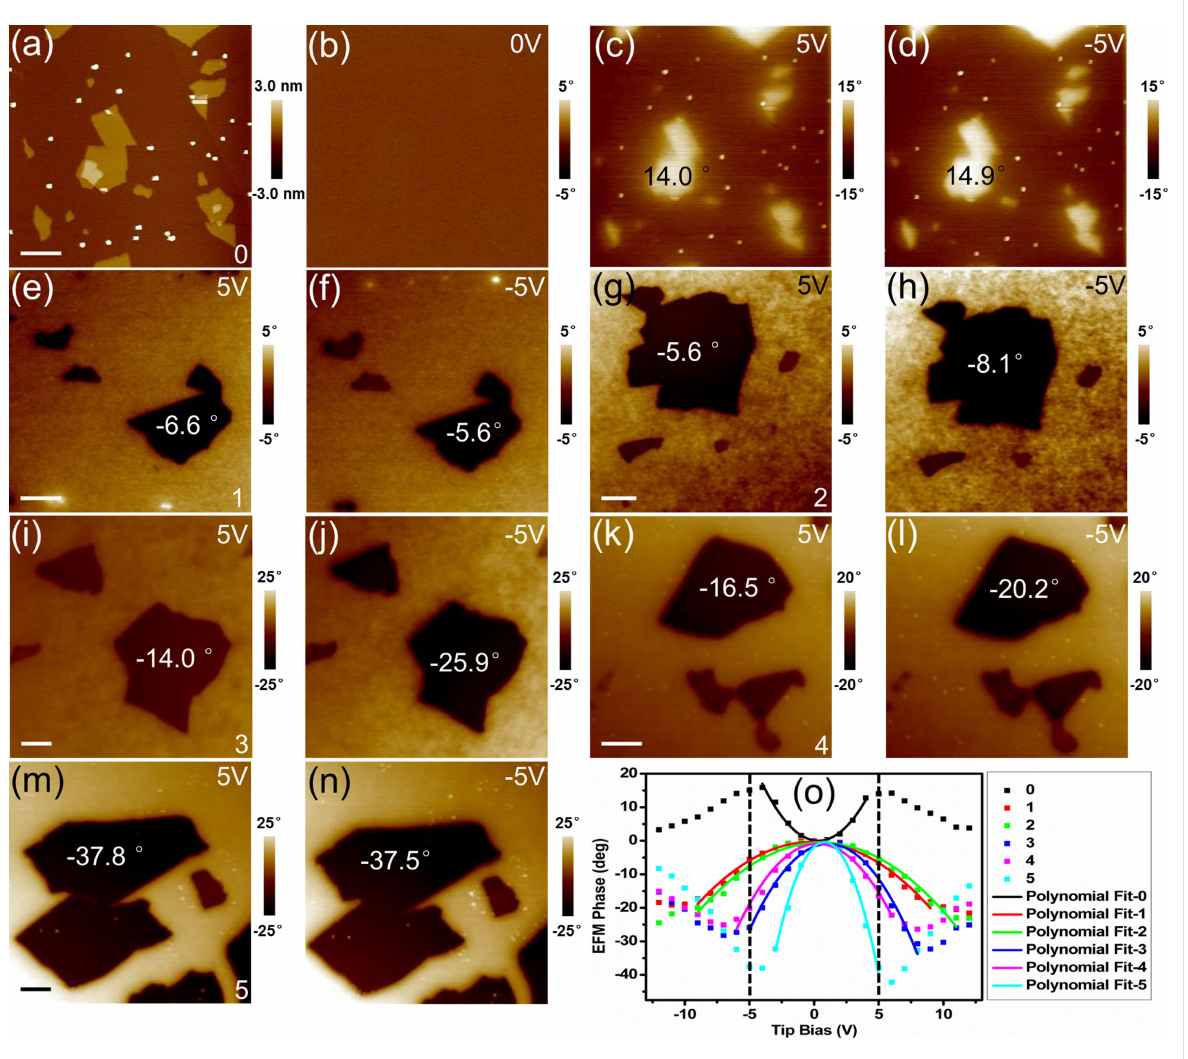
Figure 2: Characterizing the degree of reduction of GO sheets using EFM imaging and EFS: (a) tapping AFM image and in situ EFM images with tip biases of (b) 0 V, (c) 5 V and (d) − 5 V of sample 0; EFM images of (e, f) sample 1, (g, h) sample 2, (i, j) sample 3, (k, l) sample 4, and (m, n) sample 5; (o) EFM spectra and the corresponding polynomial fits of samples 0–5 (the dashed vertical lines show the position of the biases at which images (c–n) were recorded). The number in the bottom right corner of the images represents the sample number. The upper right corner shows the tip bias used in the EFM imaging. The EFM phase contrast of the samples is labelled on the corresponding positions. The scale bars represent 1000 nm. The z -scale bar is shown to the right of each